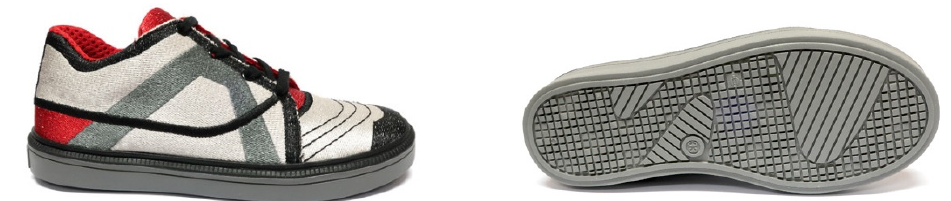
Figure 18. The sports footwear produced in industrial conditions.